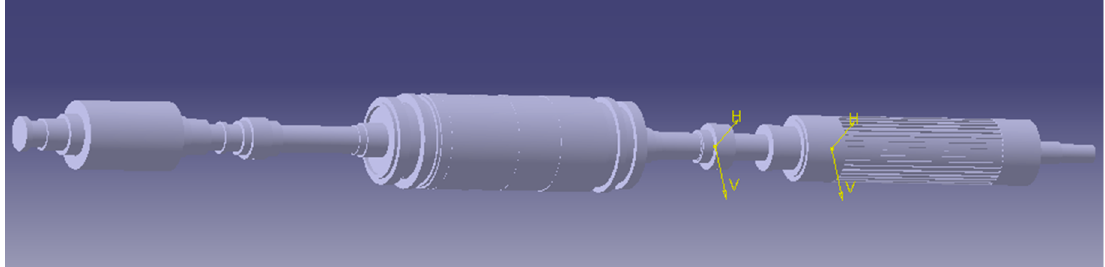
Figure 6. 3D CATIA TM model of the baseline AM600 T/G shaftline.